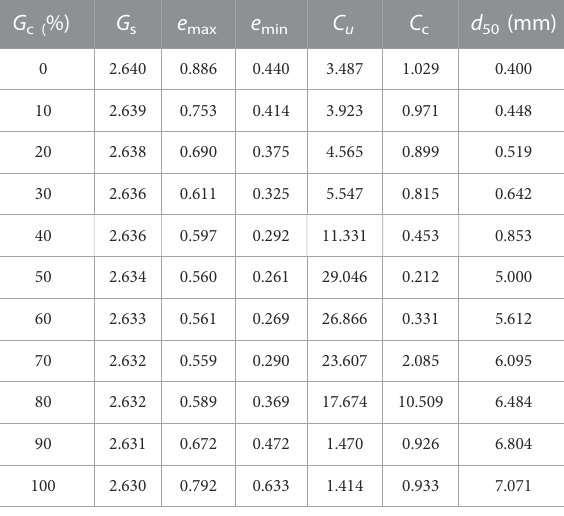
TABLE 1 Basic properties of the tested sand-gravel